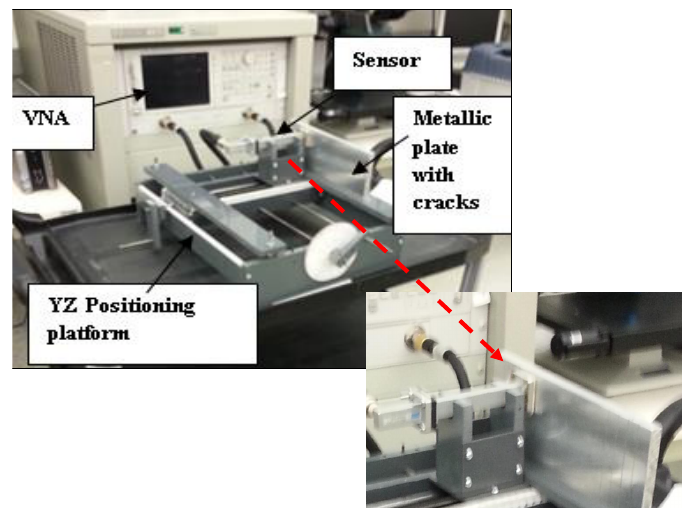
Figure 3. Photograph of the experimental configuration. The scanning along y-axis at 0.5 mm standoff.